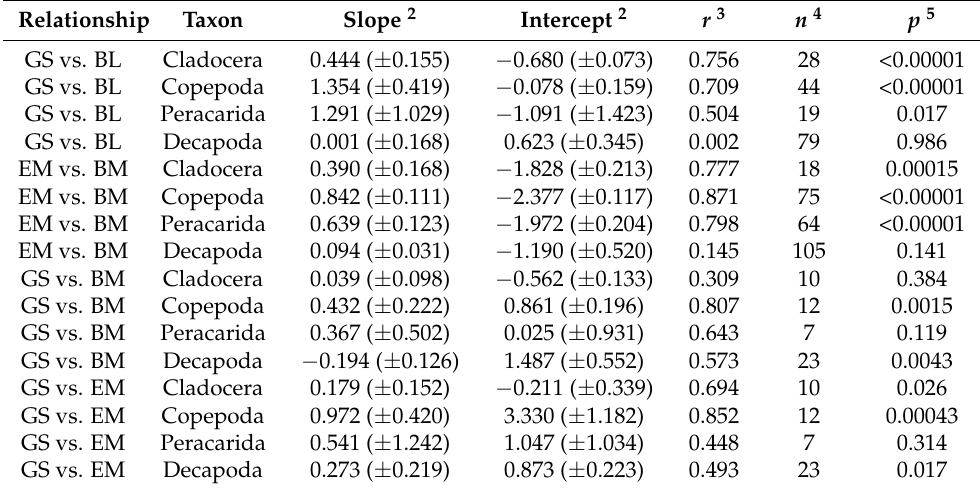
Table 2. Statistical details for scaling relationships between log 10 -transformed values of genome size (GS, pg) versus body length (BL, mm) or wet body mass (BM, mg), wet egg mass (EM, mg) versus wet body mass, and genome size versus wet egg mass for each of four major crustacean taxa 1 .